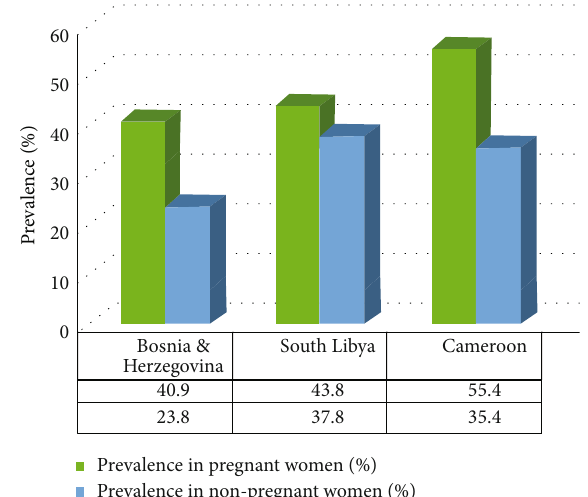
Figure 1: Di ff erence in the prevalence rate of vulvovaginal candidosis (VVC) between studied nonpregnant and pregnant women. Data was collected from 3 randomly selected comparative literature [17 – 19]. Higher prevalence of VVC among pregnant women was